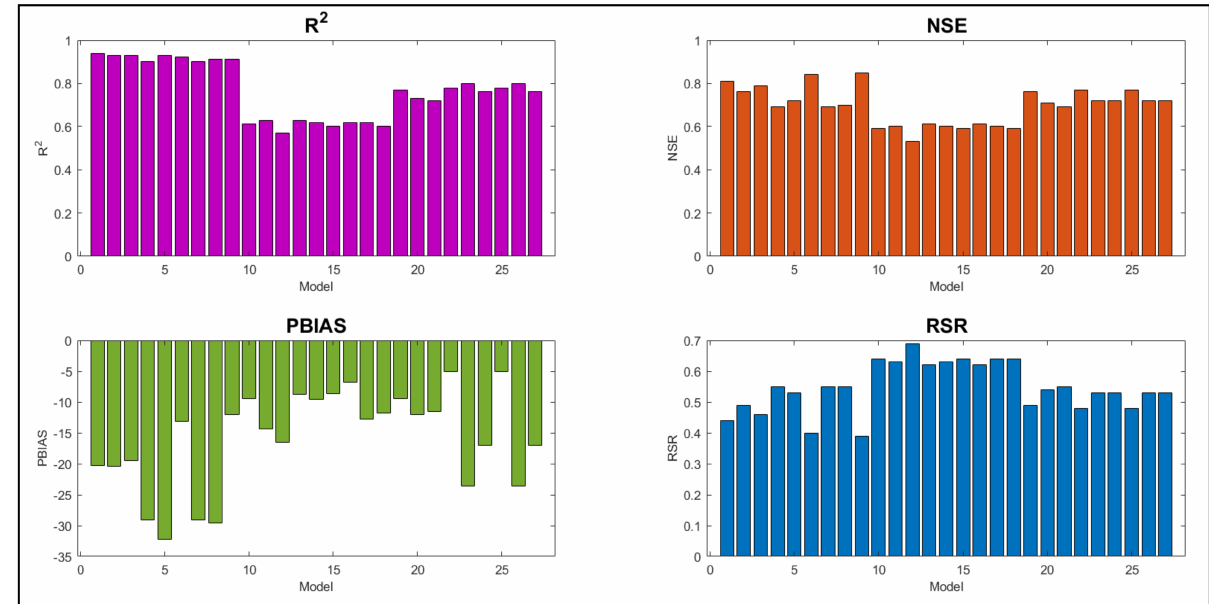
Figure 6. SWAT model performance for the 27 combinations with the four performance criteria (R 2 , NSE, PBIAS, and RSR) for the calibration period.